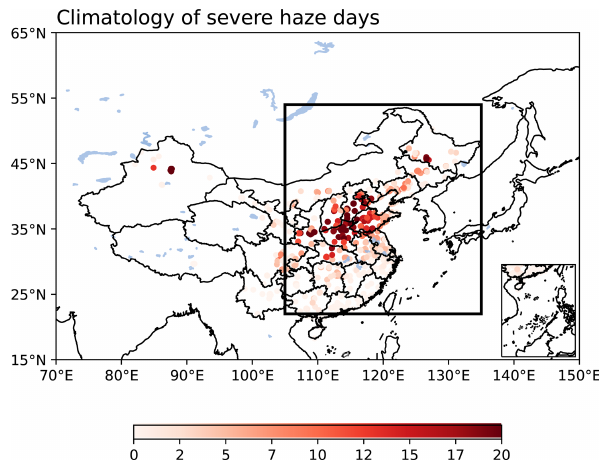
Figure 1. Spatial distribution of the annual averaged severe haze days (unit: day) in China from 2014 to 2021 in NDJF. The black box represents